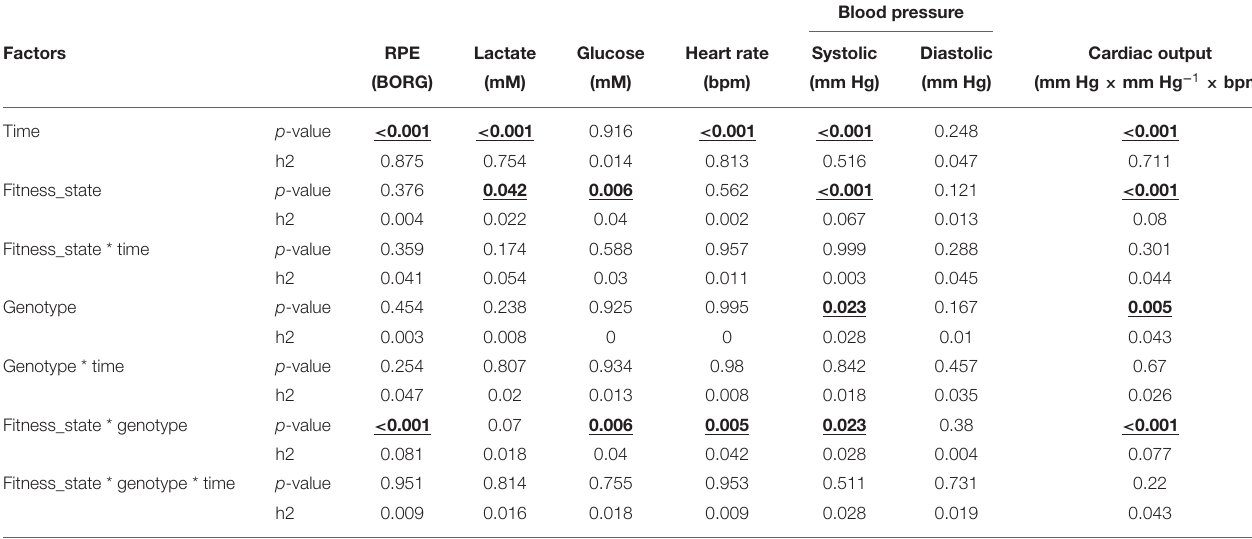
TABLE 3 | Main effects on cardiovascular parameters during ramp exercise.